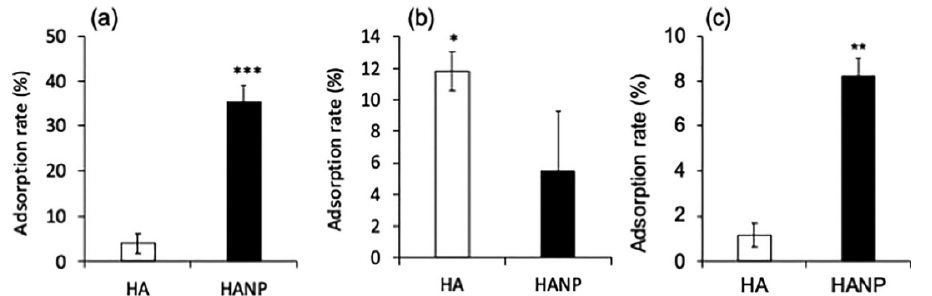
Figure 3. Adsorption of nanoparticulated-HA and HA on ( a ) phospholipid liposomes, ( b ) keratin, or ( c ) SC lipid liposomes. Values represent the mean and standard deviation (SD) of three independent results * p <0.05; ** p <0.01; *** p <0.001. Copyright 2018, with permission from Elsevier.